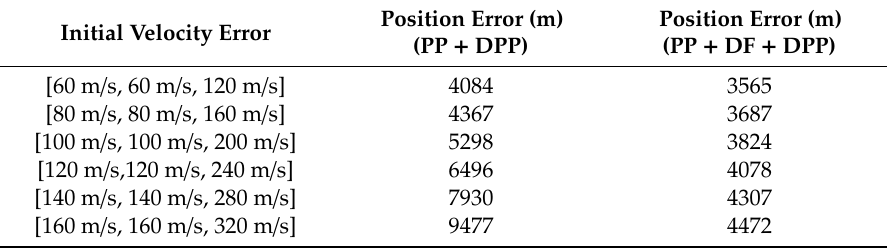
Table 5. Steady-state position estimation errors with different initial velocity error.